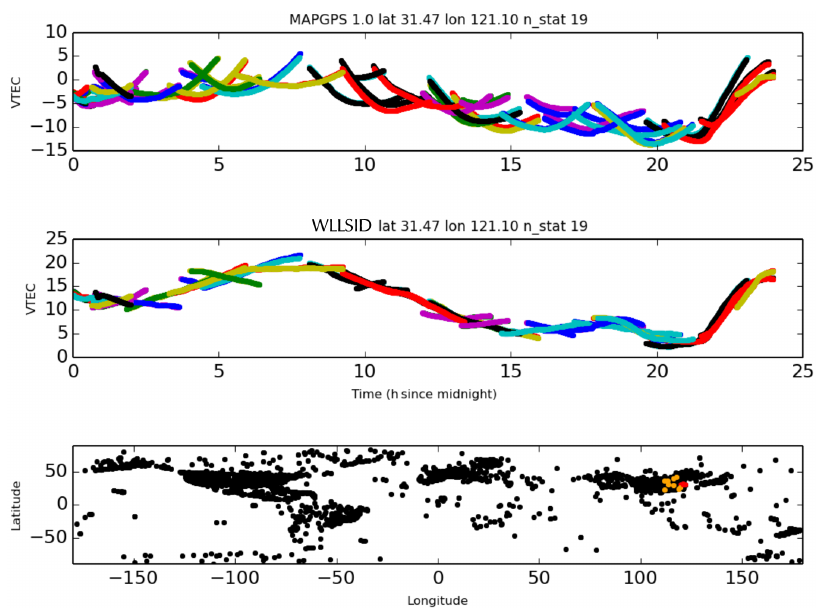
Figure 4. Vertical TEC with satellite bias estimated using the current version of the MIT Haystack Observatory MAPGPS algorithm (Rideout and Coster, 2006) shown above. Multiple receivers have problems with receiver stability, which makes the assumption of unchanging receiver bias problematic and causes the receiver bias determination to fail. Vertical TEC with receiver biases obtained using the multiple-biases assumption is shown below. The new method produces a more consistent baseline. The red dots show stations that are plotted. The algorithm uses all of the data from the 19 stations marked with orange and red dots. The stations marked with orange are used to assist in reconstruction by using a larger geographic